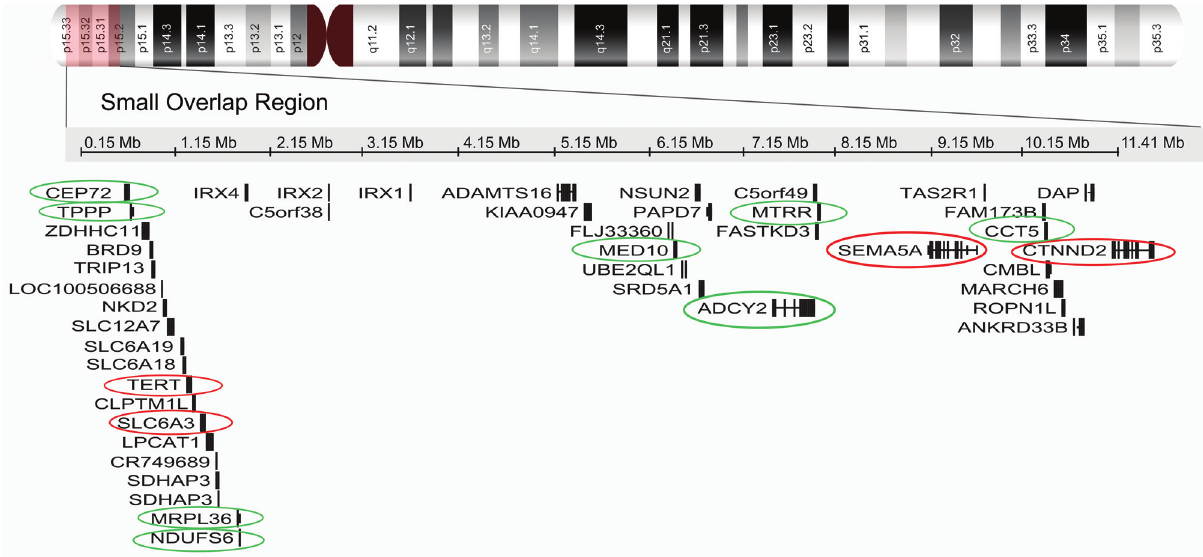
Figure 2 - Cytogenomic profile of chromosome 5. Chromosomal critical region of 5p15.33–p15.2. Genes localized to the critical region were obtained from the human assembly of February 2009 (GRCh37/hg19). Red circles show genes already associated with CdCs. Green circles show candidate genes from this study for contributing to the phenotype in